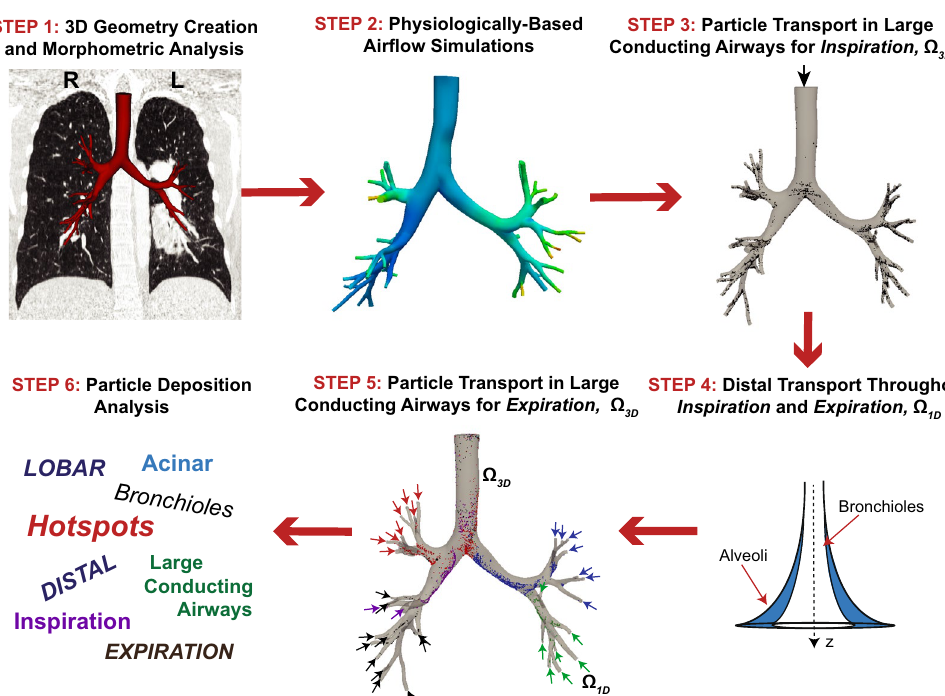
Figure 1. Simulation pipeline for the multi-dimensional airflow and transport simulations. Airway geometries were previously created from CT images and airway morphometry was measured from the geometric models (Step 1) 34 . In Oakes et al. 34 airflow was simulated throughout the respiration cycle by a pressure differential that overcame the respiratory resistance and compliance to drive air in and out of the lungs (Step 2). Particles are then tracked throughout the respiration cycle by first calculating their individual trajectories in the 3D models for inspiration (Step 3). Next, the aerosol bolus is convected through the distal regions of the lung by solving reduced-order models with a deposition loss term (Step 4). Finally, the particle trajectories are solved throughout expiration in the 3D airways (Step 5) and the regional deposition patterns are assessed (Step 6).